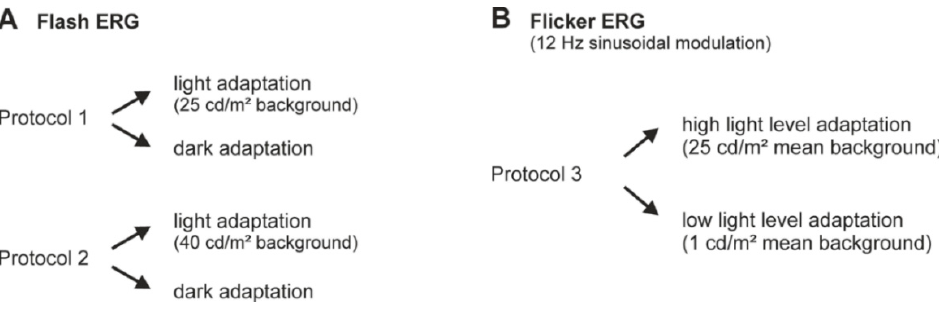
Figure 6. Scheme of the experimental procedures. The study consisted of two major parts: recordings with a conventional short-flash ERG (6.3 cd.s/m 2 flash strengths) ( A ) and with a sine wave modulation ( B ). The short-flash ERGs were performed with two separate protocols, which differed in the intensity of the adapting light. Each of the protocols consisted of a light and a dark adaptation period. ( B ) The flicker ERG response to sine-wave luminance modulation was divided into adaptation periods for high (25 cd/m 2 ) and low (1 cd/m 2 ) mean luminances.